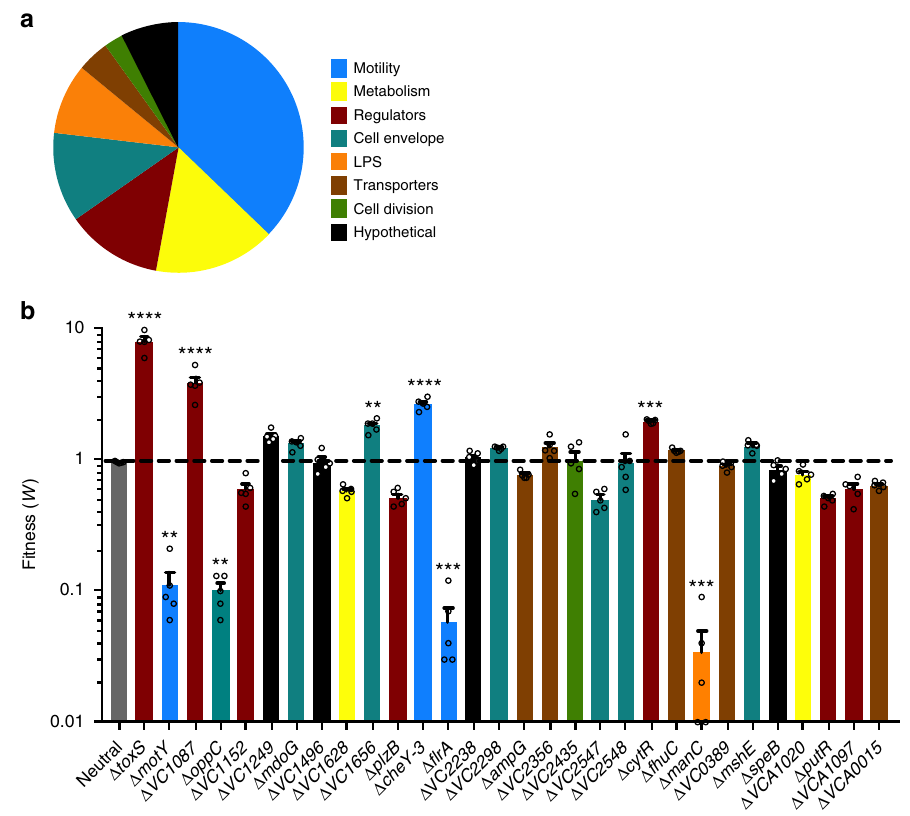
Fig. 1 V. cholerae mutants with altered sensitivity to B. bacteriovorus predation. a We generated a complex V. cholerae transposon mutant library and subjected it to transposon-insertion sequencing (Tn-seq) before and after predation by B. bacteriovorus . Mutants with decreased fi tness ( w < 0.4) are shown and categorized according to gene ontology terms. b Promising transposon mutants identi fi ed in a were re-created by gene deletion and replacement with an FRT scar. This FRT scar served as a pseudo-transposon for a mini Tn-seq of a much smaller mutant library: 32 mutants compared to 50,000 in the initial Tn-seq. The color scheme of a matches b . The average fi tness values and standard errors of the mean (SEM) for fi ve biological replicates are shown. Error bars represent standard error of the mean. Signi fi cance was determined by comparing the fi tness of each mutant to the average fi tness values for two neutral genes. ** P < 0.002; *** P < 0.0007; **** P < 0.0001 (ANOVA and Dunnett ’ s multiple comparisons